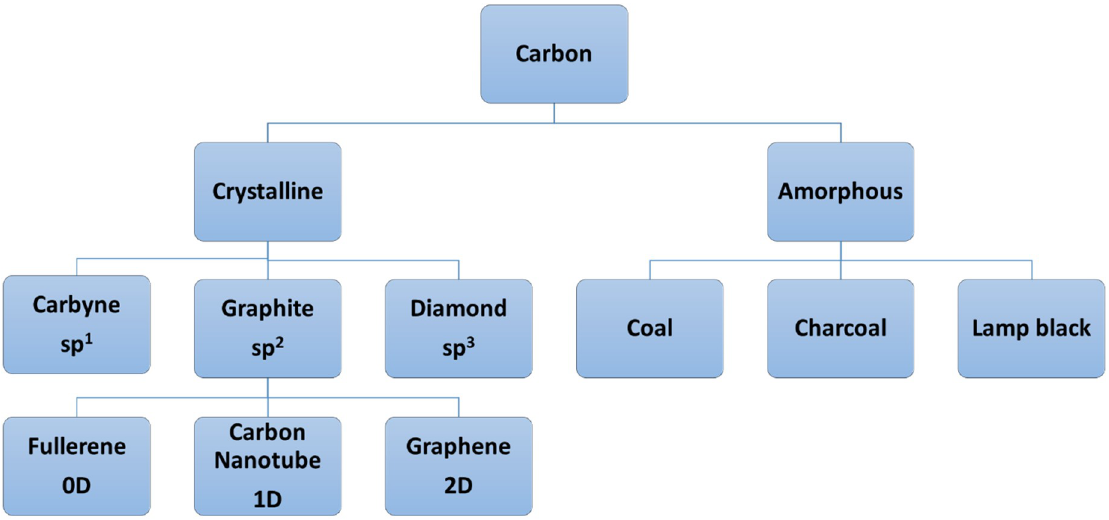
Figure 5. A broad classification of Carbon and its structures (0D, 1D and 2D means zero dimensional, one dimensional and two dimensional, respectively).